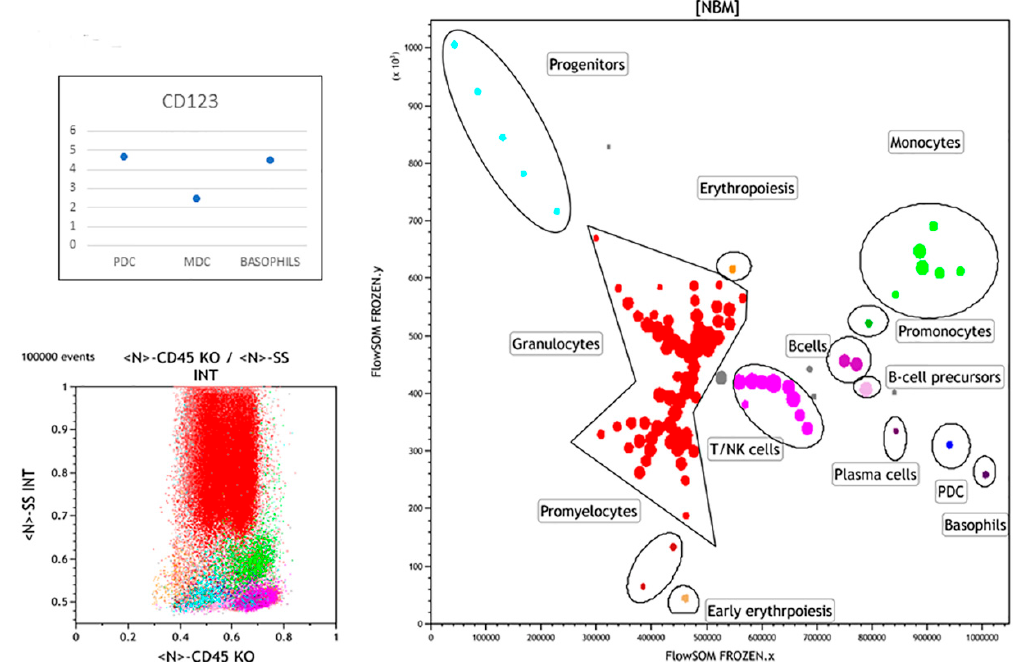
Figure 1. FlowSOM analysis of the merged normal bone marrow files showing the subsets delineated with the applied panel (Supplementary Table S3). Plasmacytoid dendritic cells (PDC) segregate as a single node between basophils and plasma cells on the right side of the minimal spanning tree. The left upper panel shows the normalised MFI expression of CD123 in these subsets and the left lower panel illustrates back-gating of cell subsets on the CD45/SSC plot.